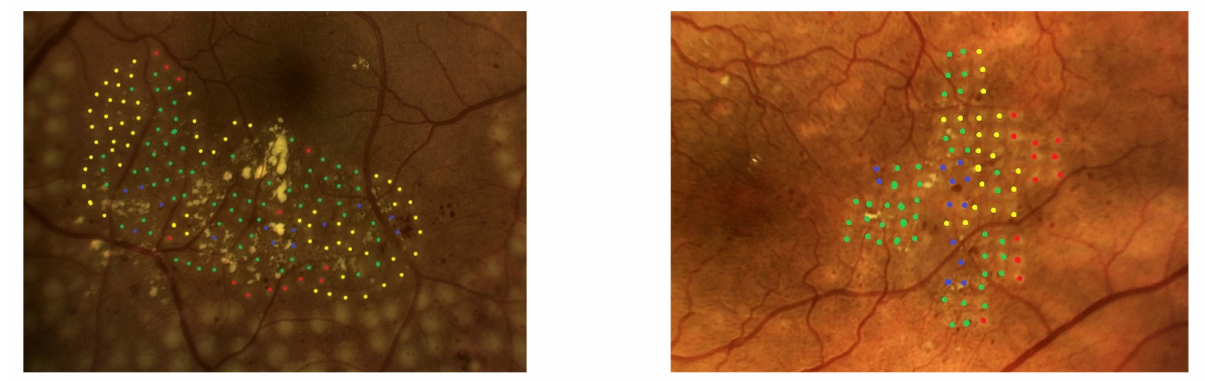
Figure 3. Examples of medical marking of coagulates in fundus images. Based on 100 marked images, a training sample was formed containing image frag- ments of the right eyes grouped by classes: optic disc—574,752 fragments; macula— 708,755 fragments; vessels—126,692 fragments; newly formed vessels—2 fragments;